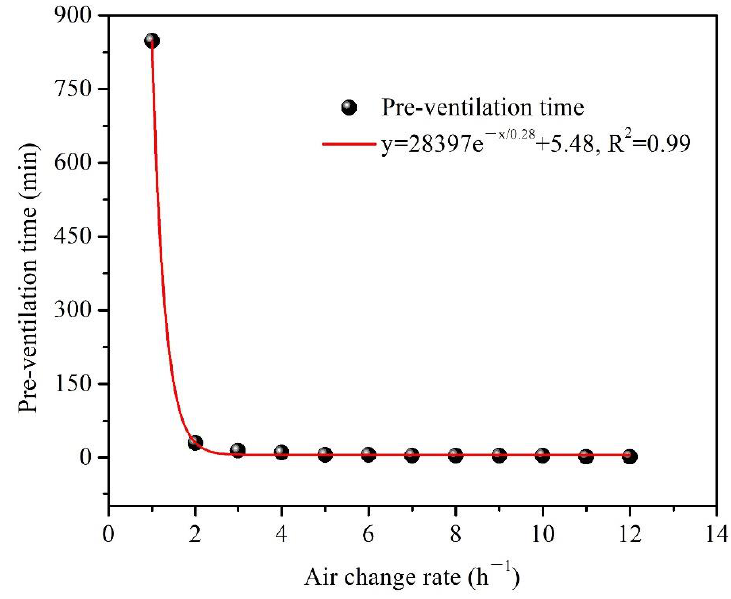
Figure 13. The relationship between the pre-ventilation time and the air change